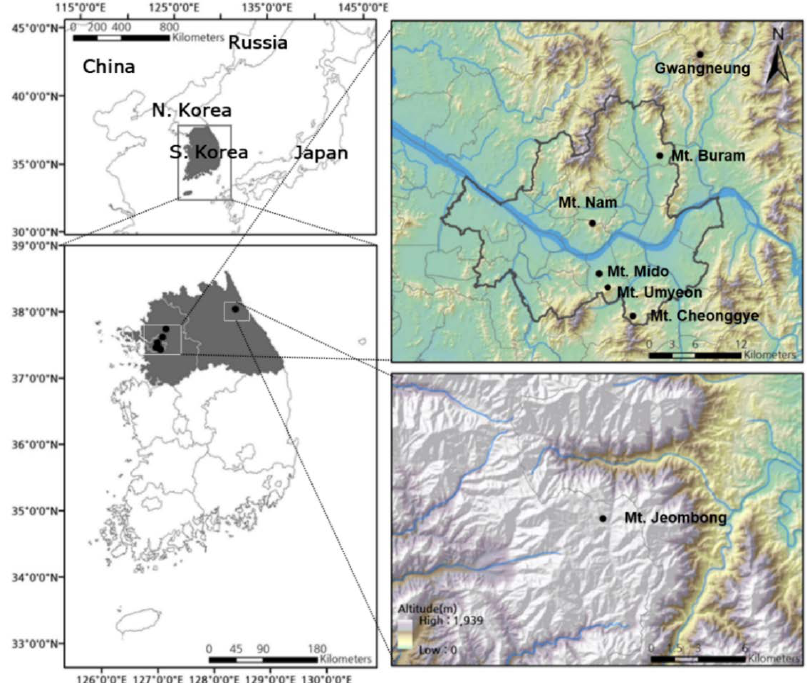
Figure 1. A map showing the location of the study sites. Table 1. Description of study sites. DoY : day of year.